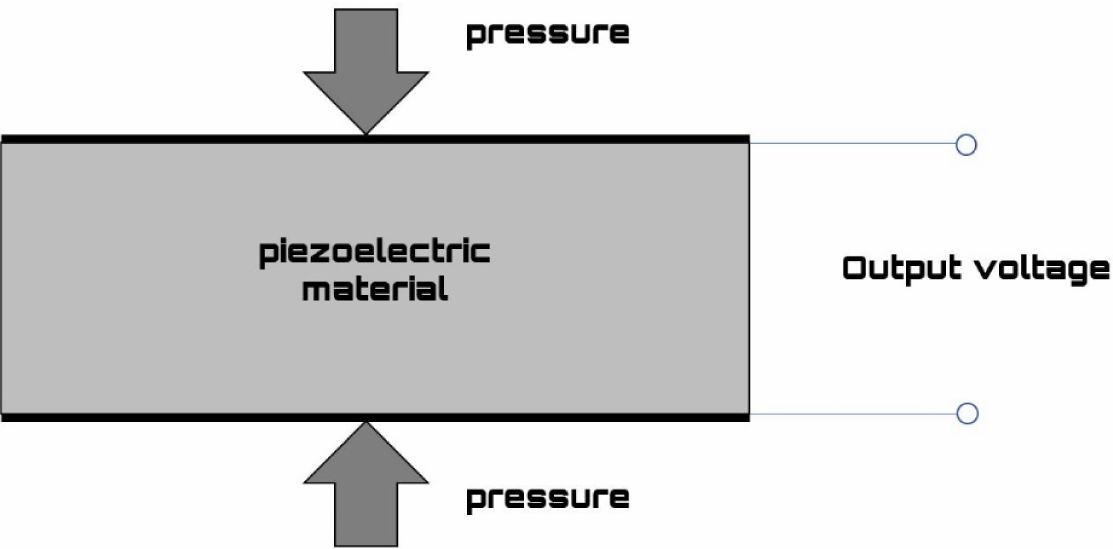
Figure 2. Piezoelectric sensor scheme: they consist of thin layers of single crystal, which produces an electrical charge when subjected to compressive